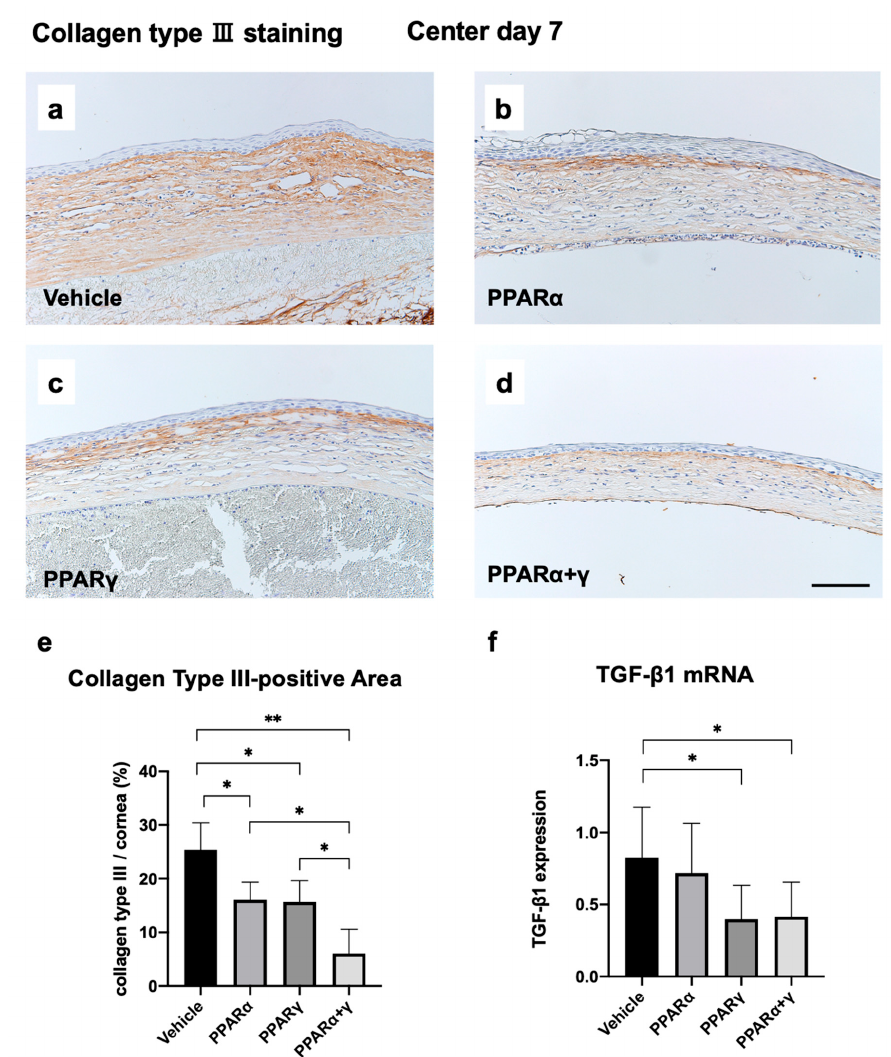
Figure 10. Immunohistochemical analysis of collagen type III to evaluate fibrotic changes at seven days after the alkali injury ( a – f ). Collagen type III was observed in the injured area during the healing process in the vehicle group ( a ). Instillation of each PPAR reduced collagen type III expression ( b–d ). Bar chart of percentages of collagen type III expression area / cornea area showed that the PPAR α + γ group had a significantly lower percentage of collagen type III compared to other groups ( e ). Real-time RT-PCR showed marked suppression of TGF- β mRNA expression in the burned cornea after PPAR γ or PPAR α + γ agonist treatment compared with the vehicle group ( f ). Bar, 100 µ m. Data are presented as the mean ± standard error ( n = 8 samples / group). ** p < 0.01, * p <